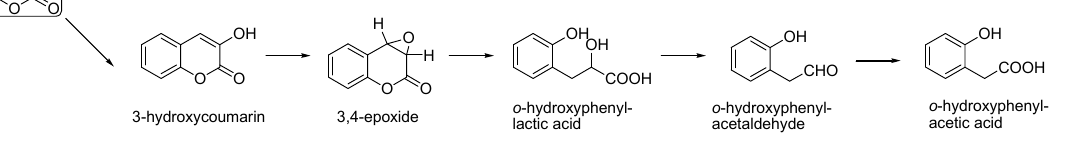
Figure 2. Coumarin metabolism.